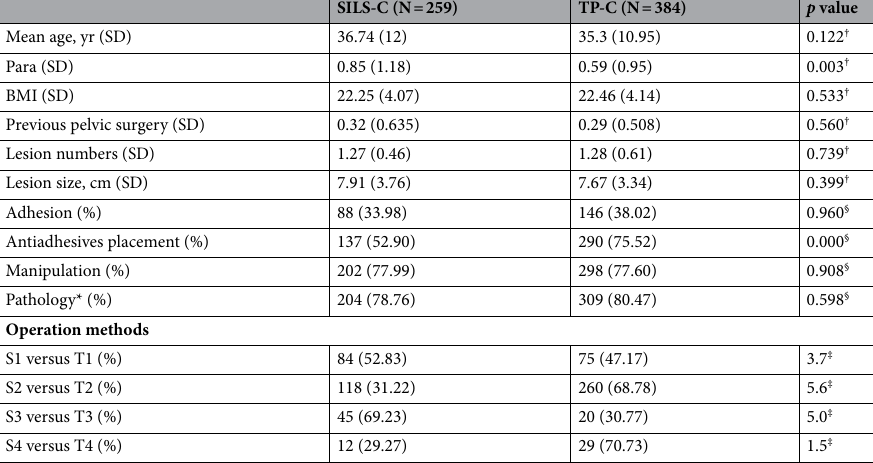
Table 1. Patient characteristics by surgical approach. † Student t test. § Chi-Square. *The pathology with pelvic adhesion (Refer to Table 4). ‡ The adjusted standardized residual. If the value is greater than 2, it indicates the proportion is significantly different at p < 0.05 level. S1: single incision unilateral adnexectomy. T1: two-port laparoscopic adnexectomy. S2: single incision unilateral cystectomy. T2: two-port laparoscopic unilateral cystectomy. S3: single incision bilateral adnexectomy. T3: two-port laparoscopic bilateral adnexectomy. S4: single incision bilateral cystectomy. T4: two-port laparoscopic bilateral cystectomy.